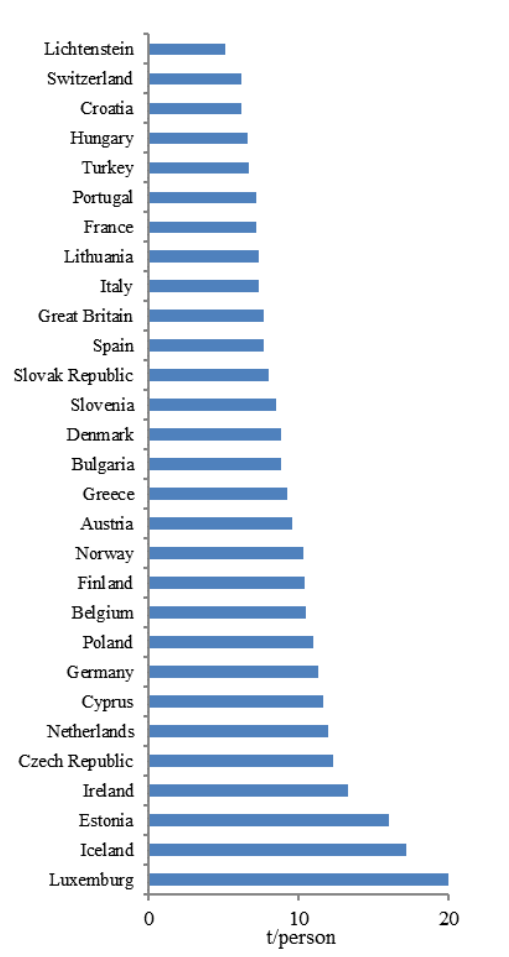
Figure 2. Greenhouse gas emissions in tonnes per capita for 2017, according to the European Environment Agency